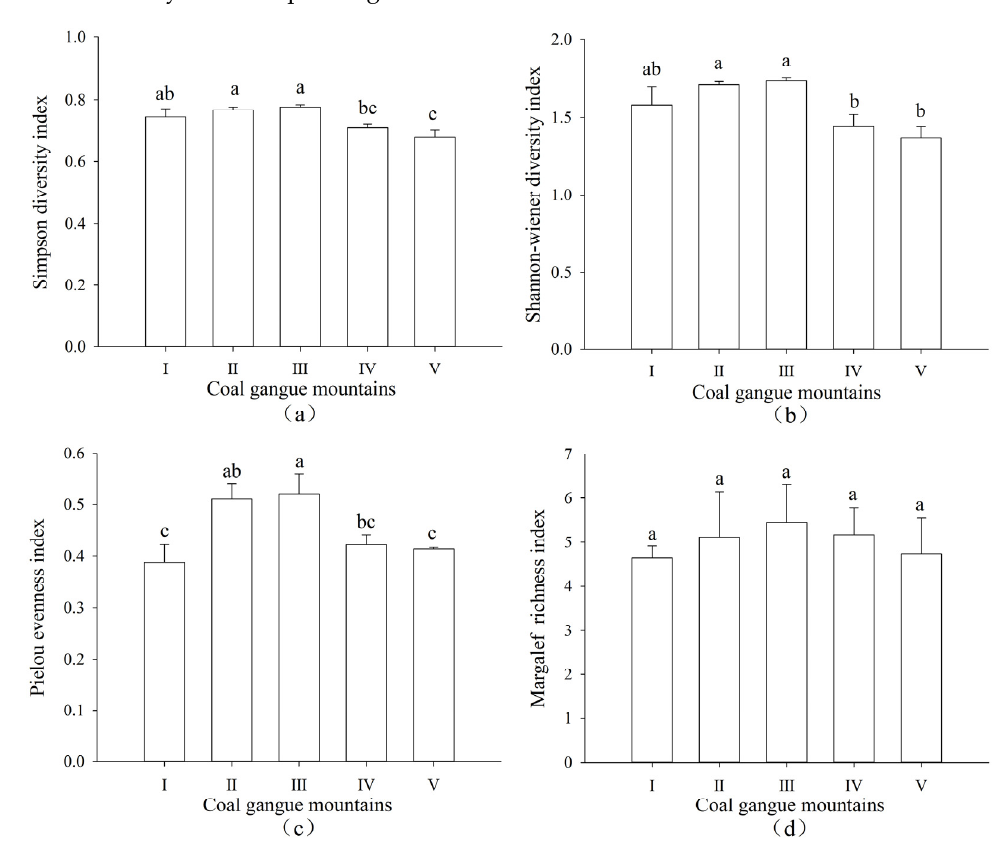
Figure 2. The Simpson diversity index ( a ), Shannon-wiener diversity index ( b ), Pielou evenness index ( c ), and Margalef richness index ( d ) of plant communities in different coal gangue mountains. (Note: Different lowercase letters indicate significant differences at the level of 0.05. “I”, “II”, “III”, “IV”, and “V” correspond to the five coal gangue mountains 3, 6, 8, 10, and 13 years after planting, respectively). Table 4 . β diversity matrix of plant communities in different coal gangue mountains.